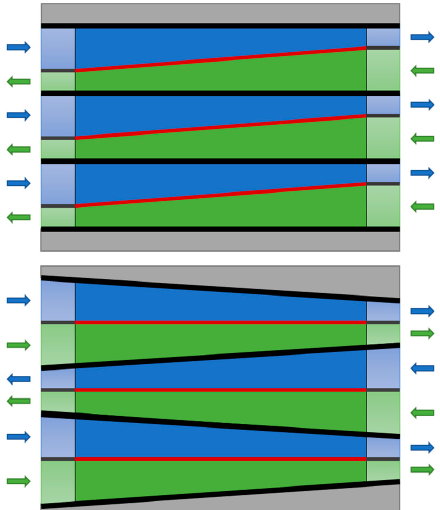
Figure 2. Possible stack configurations employing counter flow ( top ) and parallel flow ( bottom ) configurations with proposed variable porous electrode compression. A single cell with parallel flow was simulated in this study.